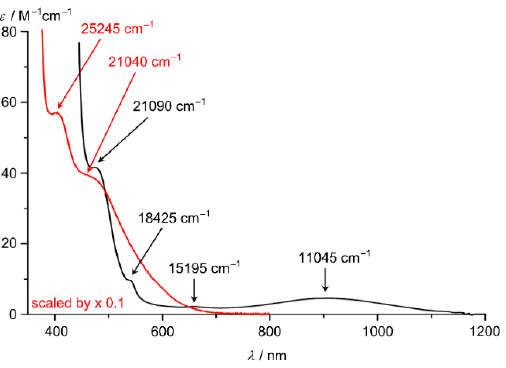
Figure 7. UV/Vis/NIR spectra of [Co(ddpd) 2 ] 2+ (black) and [Co(ddpd) 2 ] 3+ (red, scaled by 0.1) in CH 3 CN; ligand field bands indicated by arrows [62]. CH 3 CN; ligand field bands indicated by arrows